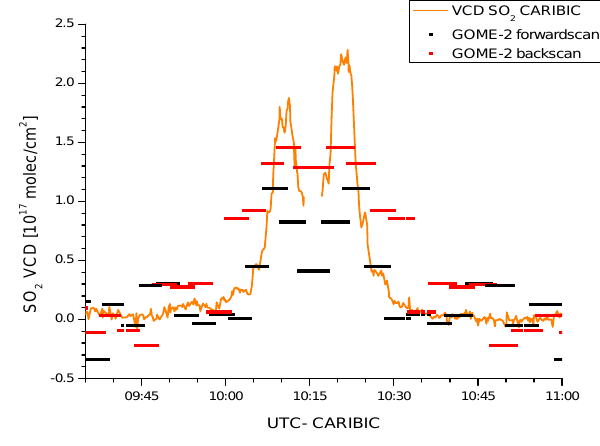
Fig. 10. SO 2 Box AMFs (315nm) for the viewing geometries used during the plume observations. The horizontal solid lines mark the flight altitude for the respective peak observation. The box covers the estimated plume altitude range (3–6km). In the simulations a cloud top height of 1.5km was assumed, which causes the second rapid decrease in the sensitivity below 1.5km.